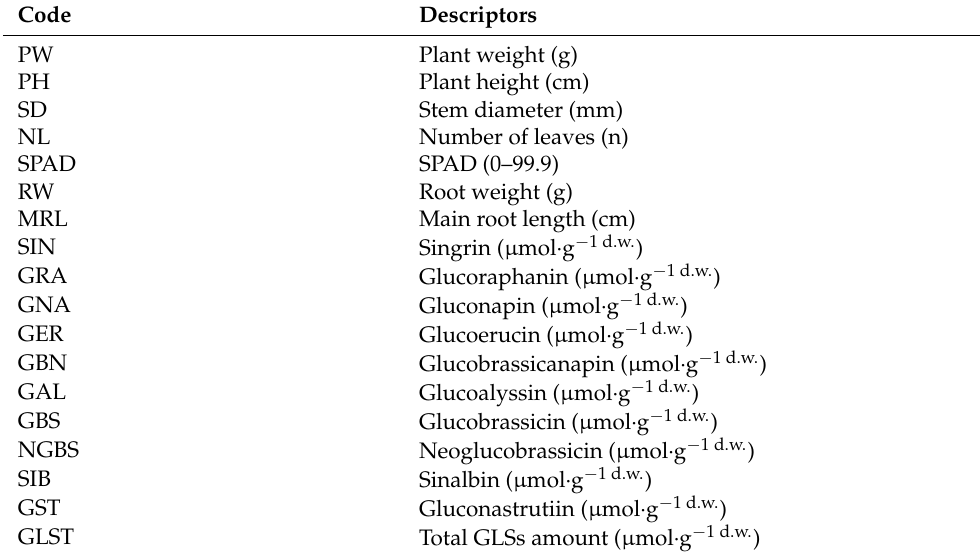
Table 1. Morphological and biochemical descriptors and their corresponding